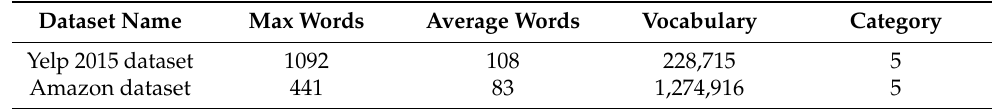
Table 1. Relevant information about the experimental